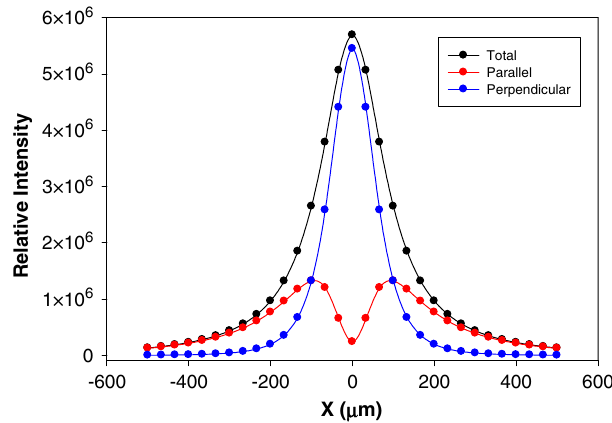
FIG. 14. Comparison of different ODR polarization compo- nents with relative intensities: total (black), perpendicular (blue), and parallel (red). The actual Gaussian beam size is 20 (cid:1) m , the height is 20 (cid:1) m , and the impact parameter is 100 (cid:1) m in the simulation